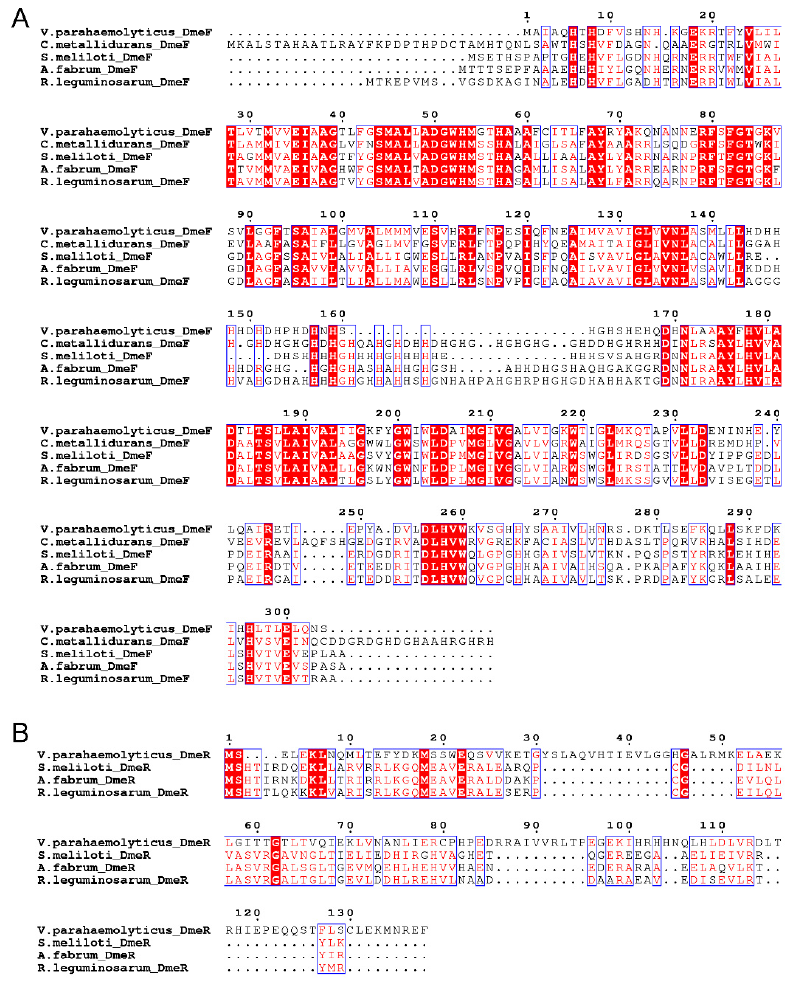
Figure 2. Multiple sequence alignments of the DmeF ( A ) and DmeR ( B ) homologues.